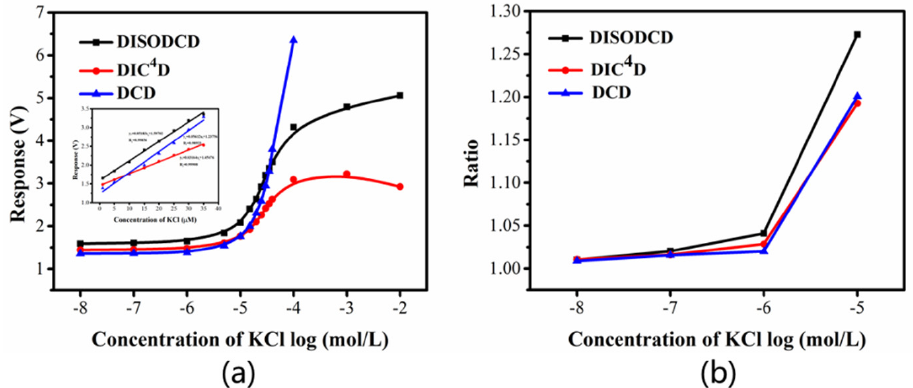
Figure 8. Response of DISODCD, DIC 4 D, and DCD to 0.01 µ M-10 mM KCl solution. ( a ) Response curve of DISODCD, DIC 4 D, and DCD. ( b ) The ratio of the response of DISODCD, DIC 4 D, and DCD.